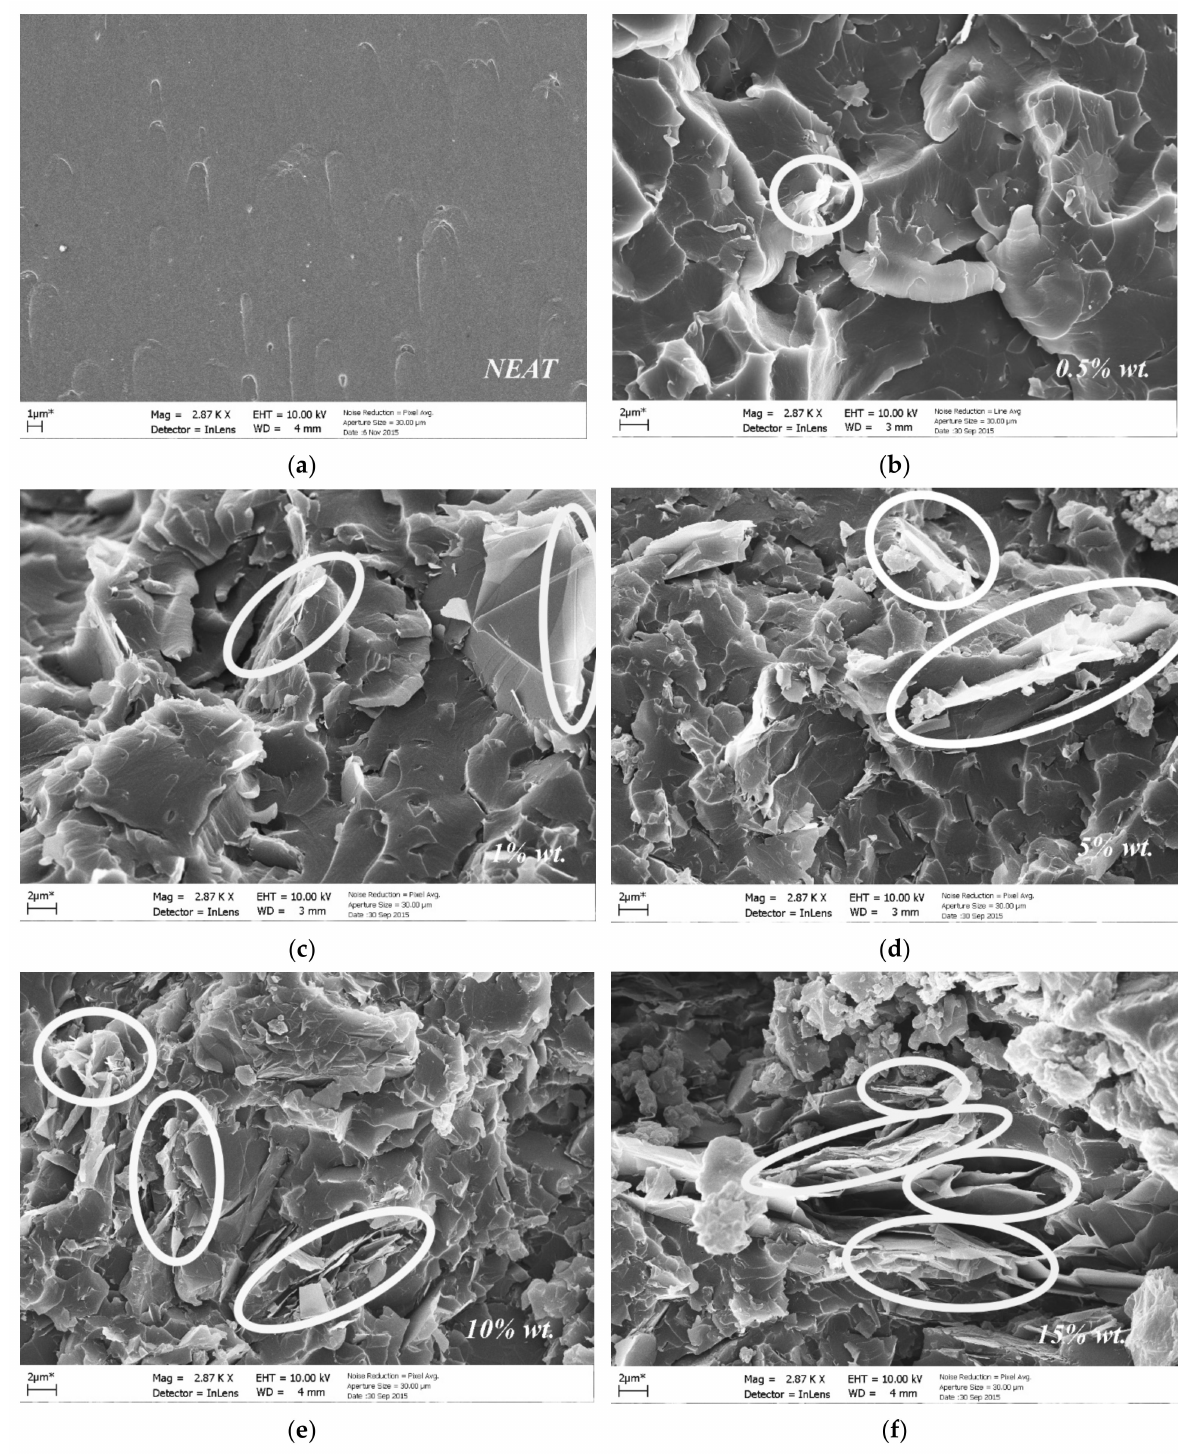
Figure 6. SEM images of the neat and nano-reinforced polymers enhanced with different contents of Type 2 GNPs: ( a ) neat, ( b ) 0.5 wt.%, ( c ) 1 wt.%, ( d ) 5 wt.%, ( e ) 10 wt.% and ( f ) 15 wt.% White circles indicate the agglomerates formed between the GNPs inside the